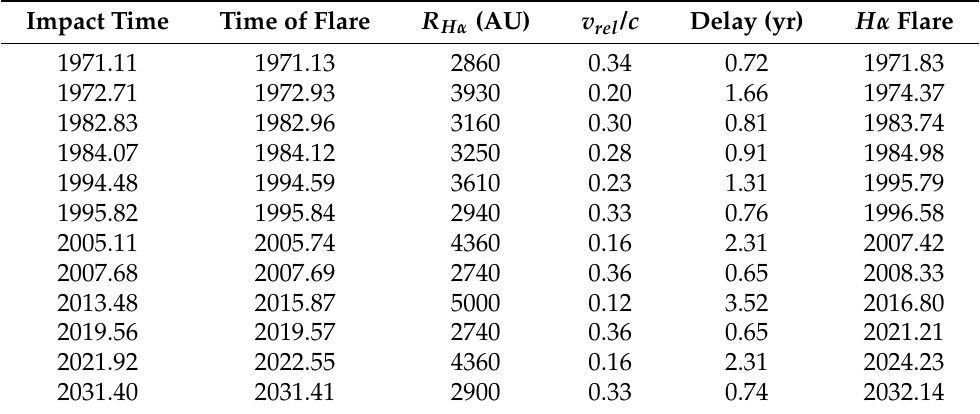
Table 1. Times of disk impacts and bremsstrahlung flares as well as the radii of the H α bubbles, impact speed on the disk, the delay of the H α flare and the time of the H α flare Impact